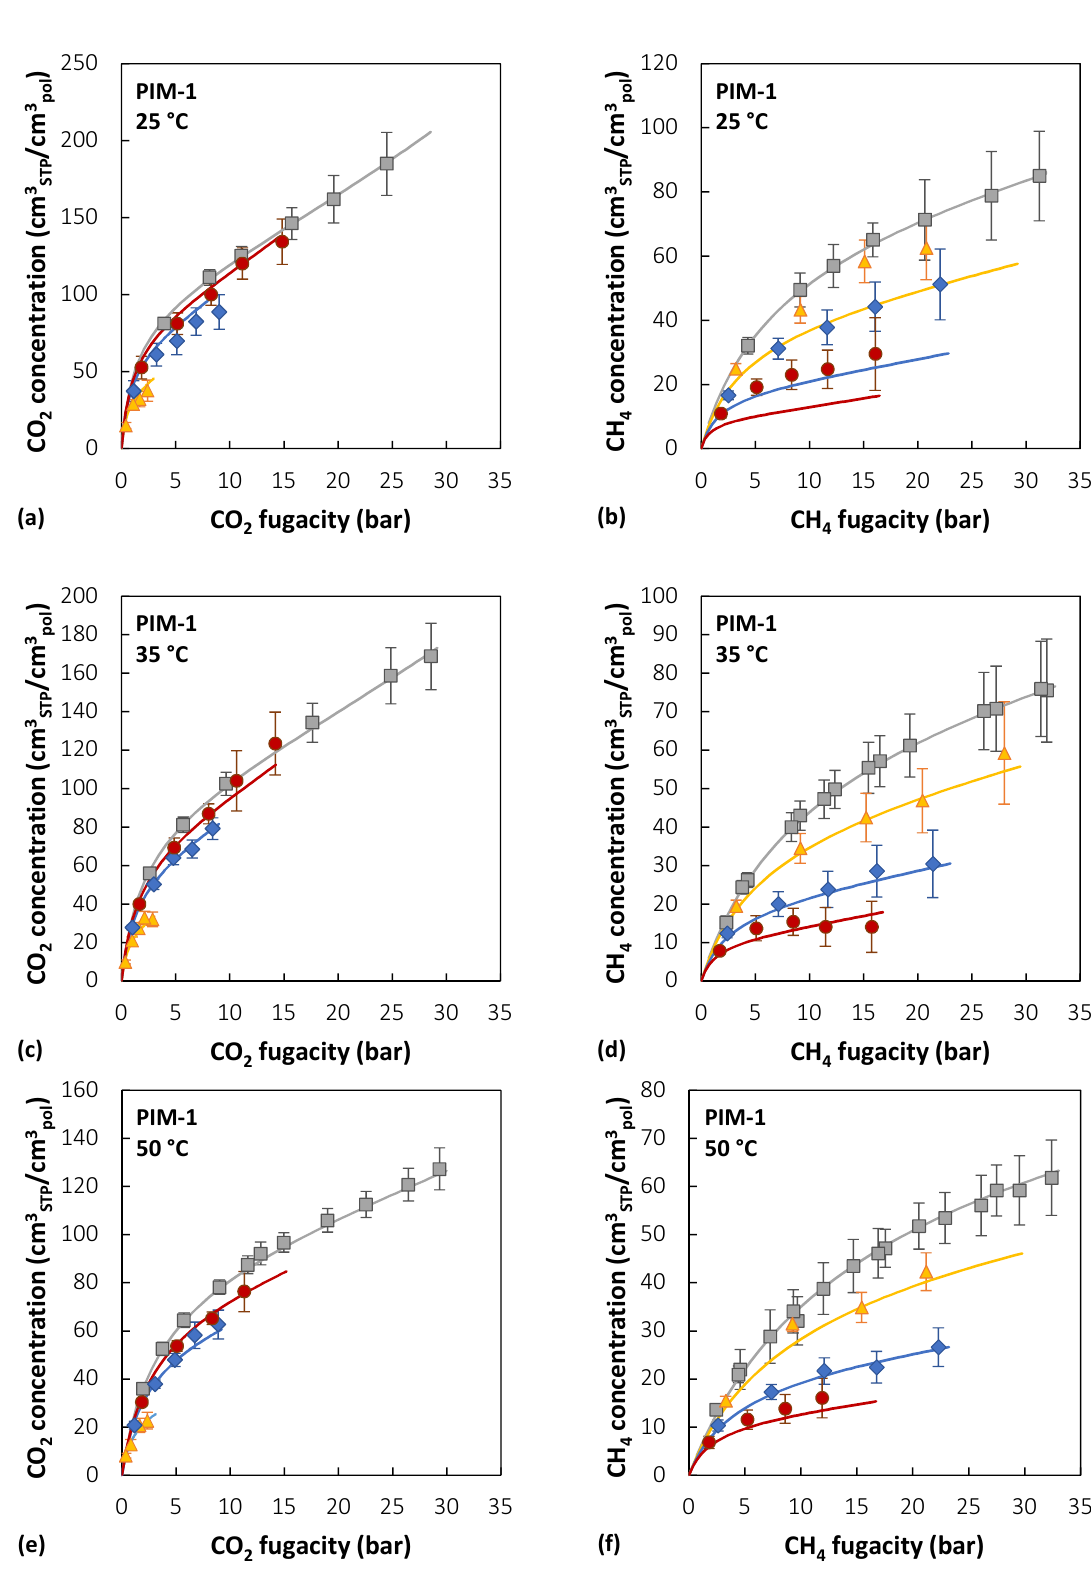
Figure 7. Sorption isotherms of ( a , c , e ) CO 2 and ( b , d , f ) CH 4 at 25, 35, and 50 ◦ C in PIM-1 in pure- and mixed-gas conditions: grey squares, pure gas; yellow triangles, ∼ 10% CO 2 mixture; blue diamonds, ∼ 30% CO 2 mixture; red circles, ∼ 50% CO 2 mixture [39,40]. Solid lines are NELF model predictions [191].